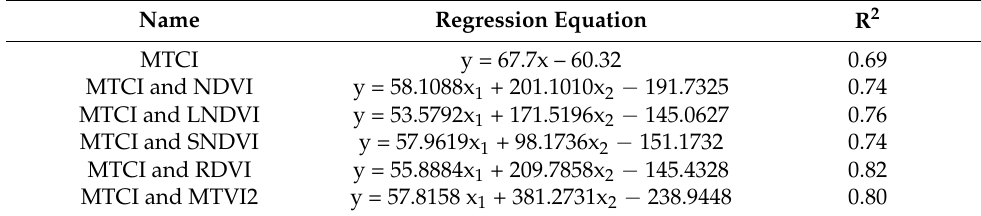
Table 6. Binary linear regression retrieval model.